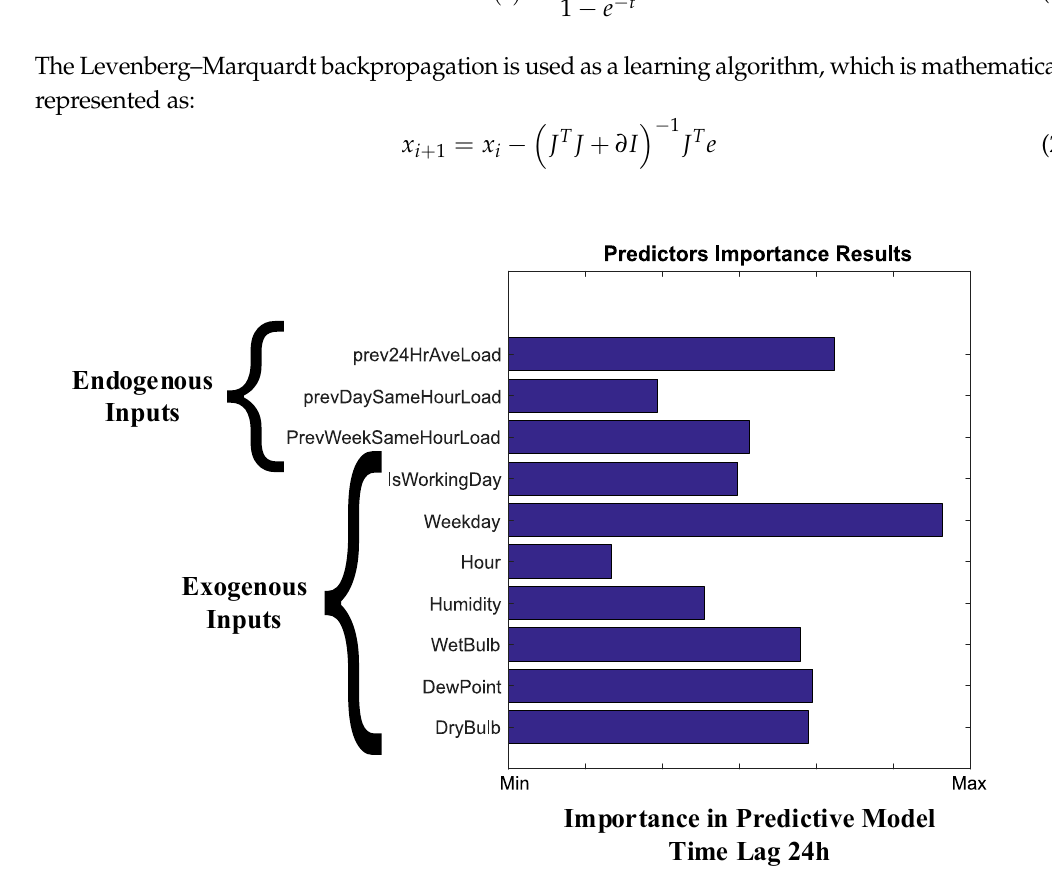
Figure 9. ANN inputs importance in predictive model.